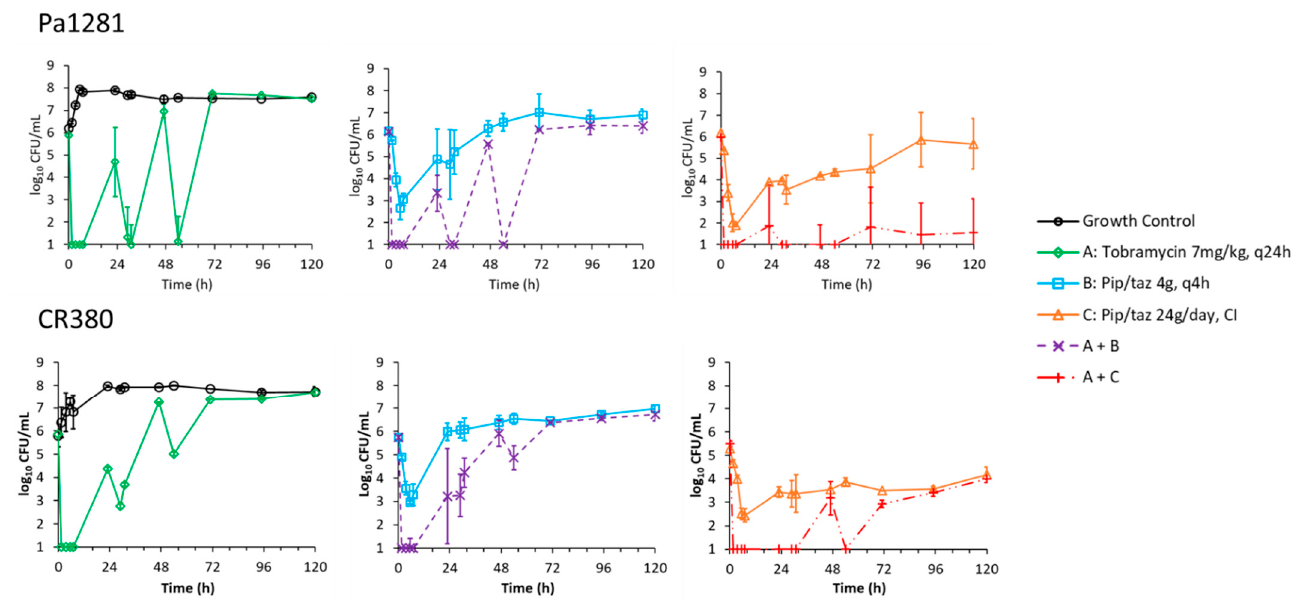
Figure 1. Counts of total viable bacteria (average ± SE a ) from the dynamic in vitro infection model of P. aeruginosa clinical isolates Pa1281 and CR380 against piperacillin-tazobactam (pip/taz) and tobramycin, alone and in combination. Observations below the limit of counting (1.0 log 10 CFU/mL) are plotted at 1.0 log 10 CFU/mL. a Performed in biological replicates, n = 2 except for CR380 vs. B and A + B where n = 3.